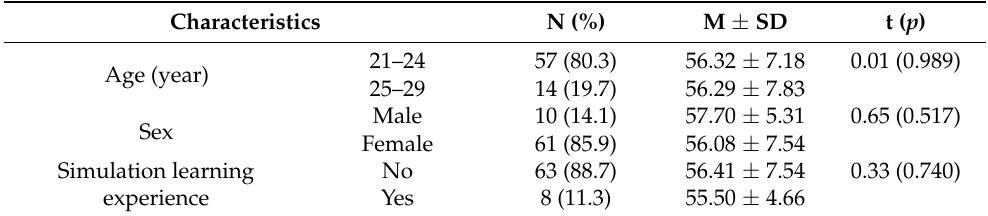
Table 3. Differences in student satisfaction with and self-confidence in learning according to partici- pant characteristics ( n = 71).